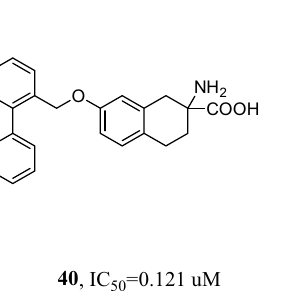
Figure 14: Chemical structures of compounds 40 – 42 .